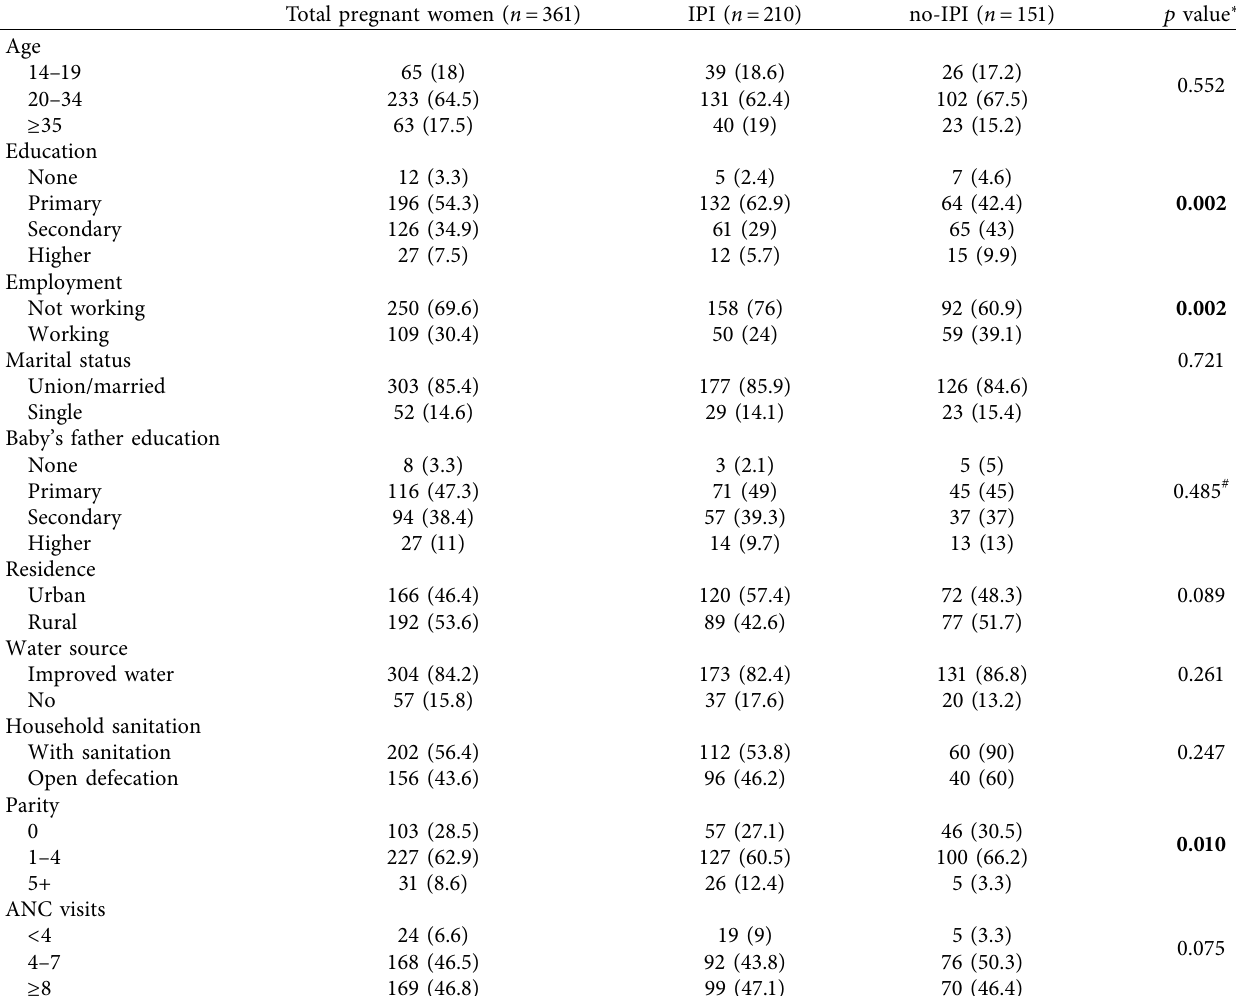
Table 1: Baseline characteristics of the study sample (361), pregnant women with IPI (210), no-IPI (151), and associations with maternal characteristics.